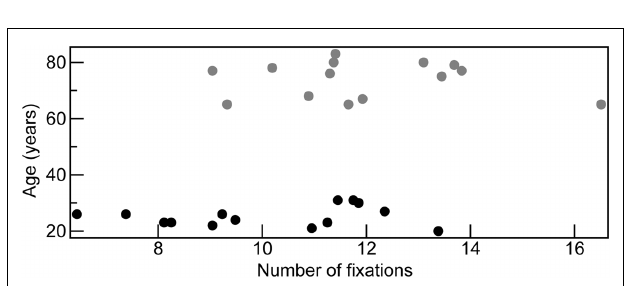
FIGURE 3 | Participants’ age crossed with the total number of fixations (collapsed across fame) made across faces with five exposures.